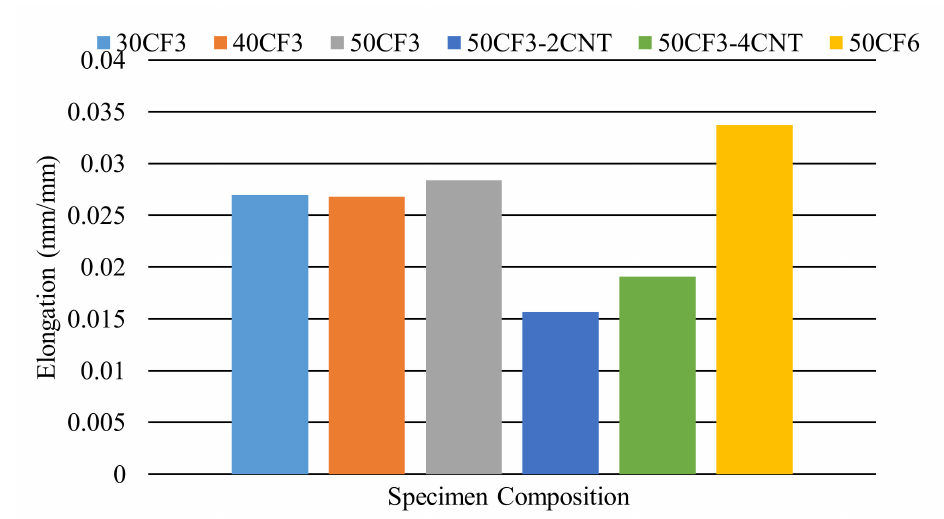
Figure 10. Average elongation for di ff erent specimen compositions. Table 4. Average and coe ffi cient of variation of elongation for di ff erent specimen compositions. Composition